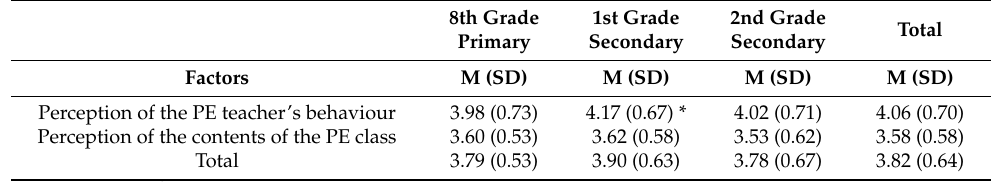
Table 5. Descriptive results of the CAPPEF factors, by